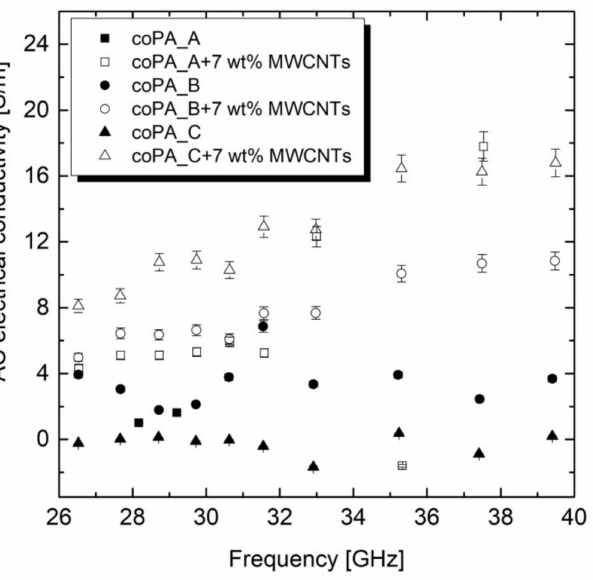
Figure 4. AC electrical conductivity measured in GHz frequency for the neat fibers and those containing 7 wt% MWCNTs. The fibers for the analysis had a similar diameter of around 100 µ